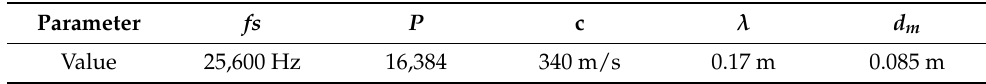
Table 1. Basic parameters of the